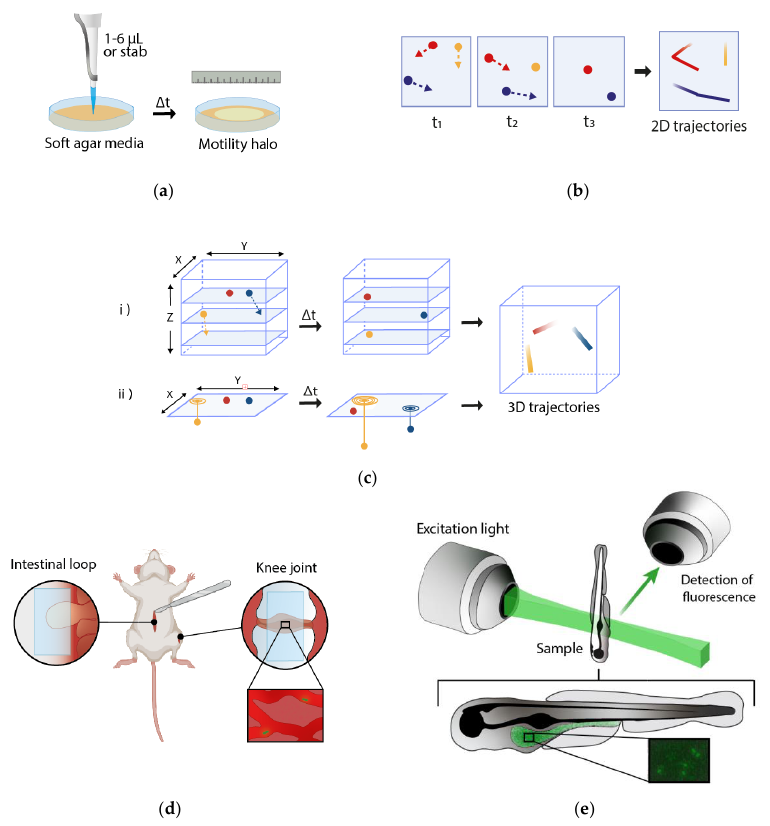
Figure 1. Some examples of methods to study bacterial motility and motility tracking. ( a ) Soft agar assay is the most common macroscopic method used to study motility. After inoculating 1 – 6 µL or a stab of bacterial culture in soft agar, motile bacteria will spread and blur the media. ( b ) Assessing motility using some common microscopic methods is based on tracking individual bacteria to obtain their 2D trajectories. If a cell leaves the focal plane (orange cell) the track ends. ( c ) Three-dimensional trajectories can be obtained by (i) stacks of 2D slices along the z-axis (z-stacking) or by (ii) projecting the 2D image in the z-axis according to certain parameters such as depth-dependent shape in the case of defocused imaging methods. ( d ) Intravital microscopy (IVM) aims to visualize phenomena occurring inside live animals. For example, exposing the tissue of an anesthetized mouse by doing small incisions while carefully preserving its physiological conditions, a glass coverslip can be placed in the knee joint [32] or an intestinal loop [33] to visualize the movement of fluorescently labeled bacteria. Bacteria (green) are shown inside knee joint microvasculature. ( e ) The optical trans- parency of zebrafish larvae allows non-invasive visualization of the in vivo motility of fluorescent bacteria with light-sheet fluorescence microscopy (LSFM) in which a focal plane is illuminated, ex- citing all points in the plane simultaneously.